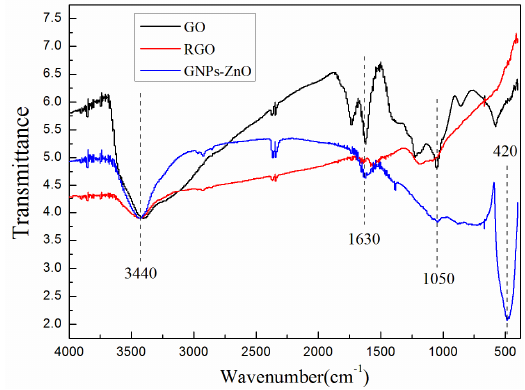
Figure 4. FTIR spectrum of GO, RGO, and GNP-ZnO hybrids.